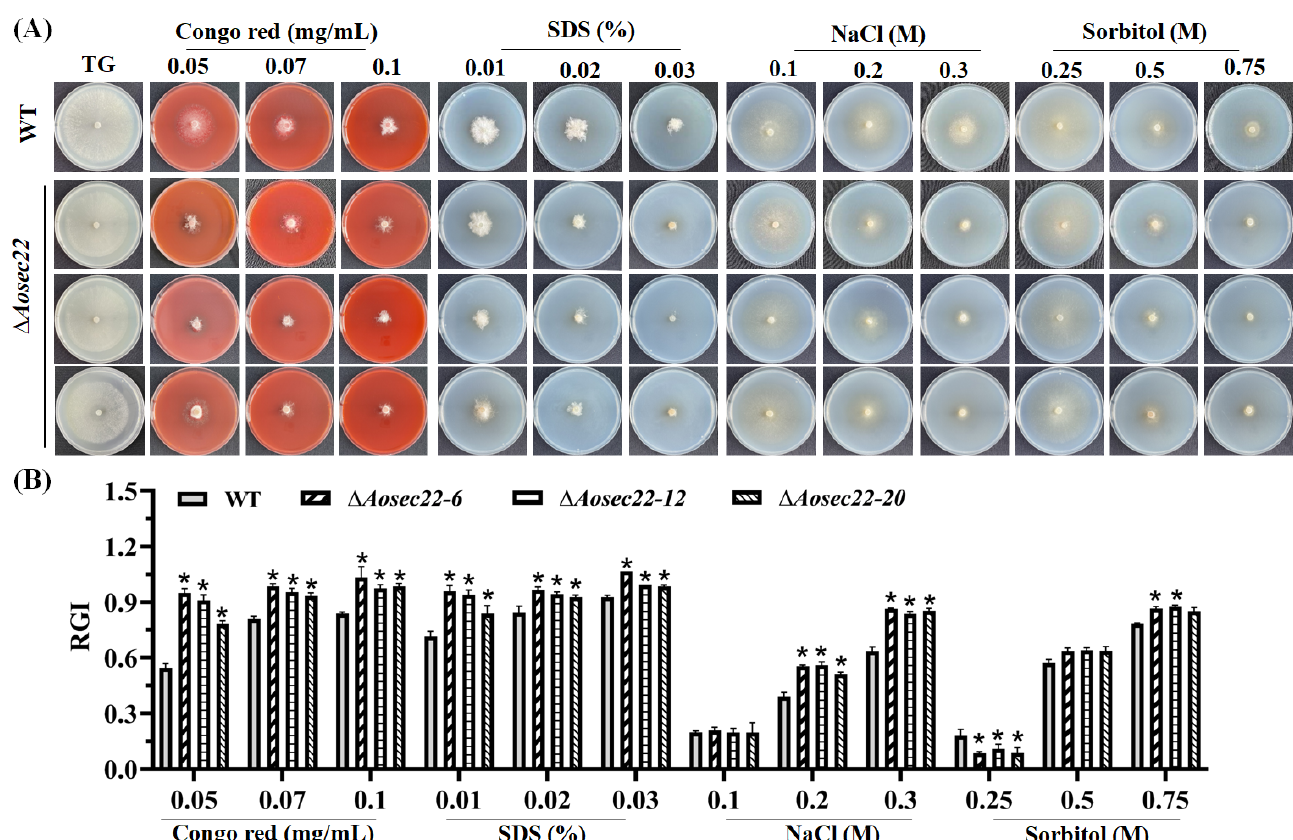
Figure 6. Comparison of stress responses between WT and ∆ Aosec22 strains. ( A ) Colonial morphology of fungal strains under osmotic and cell wall-perturbing stress. ( B ) Relative growth inhibition (RGI) of fungal colonies after 6-day incubation at 28 °C on TG plates supplemented with indicated concentrations of Congo red, SDS, NaCl, and sorbitol. An asterisk indicates a significant difference between ∆ Aosec22 mutant and the WT strain (Tukey’s HSD, p < 0.05).